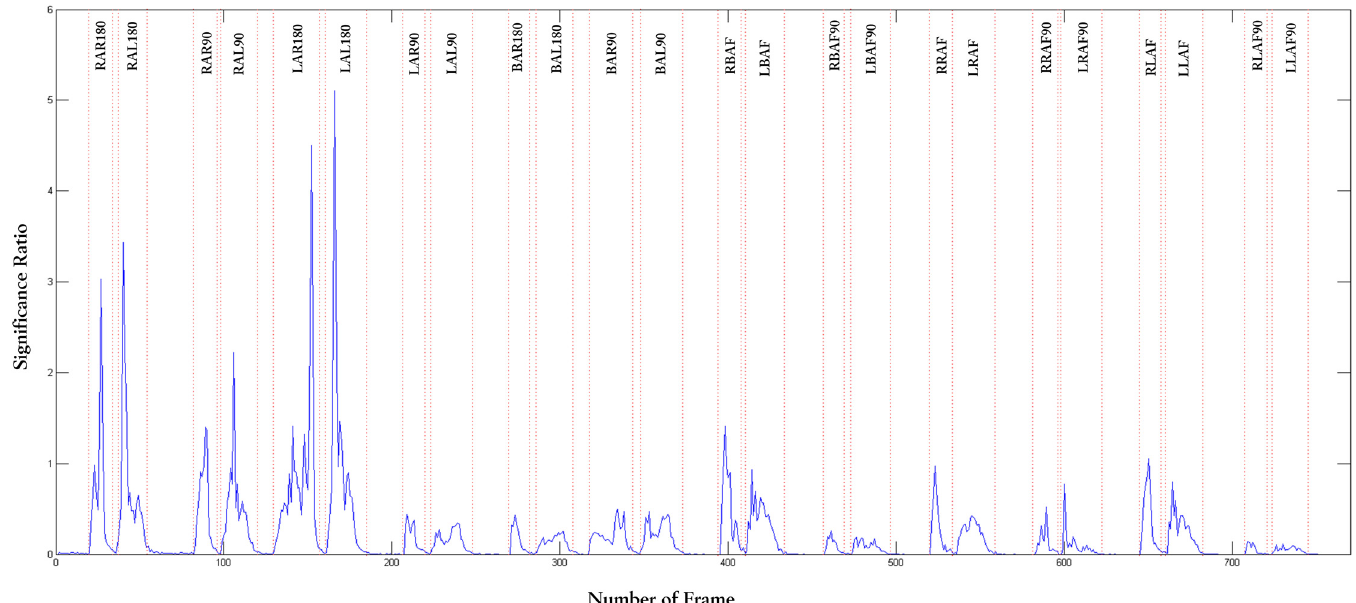
Fig 10. Output of the segmentation algorithm through Incremental Kernel Slow Feature